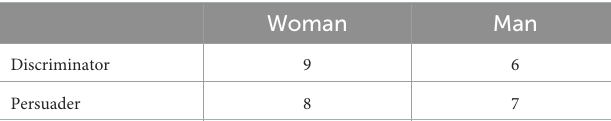
TABLE 2 Number of scenes given the gender of the actors and their roles in the scene.